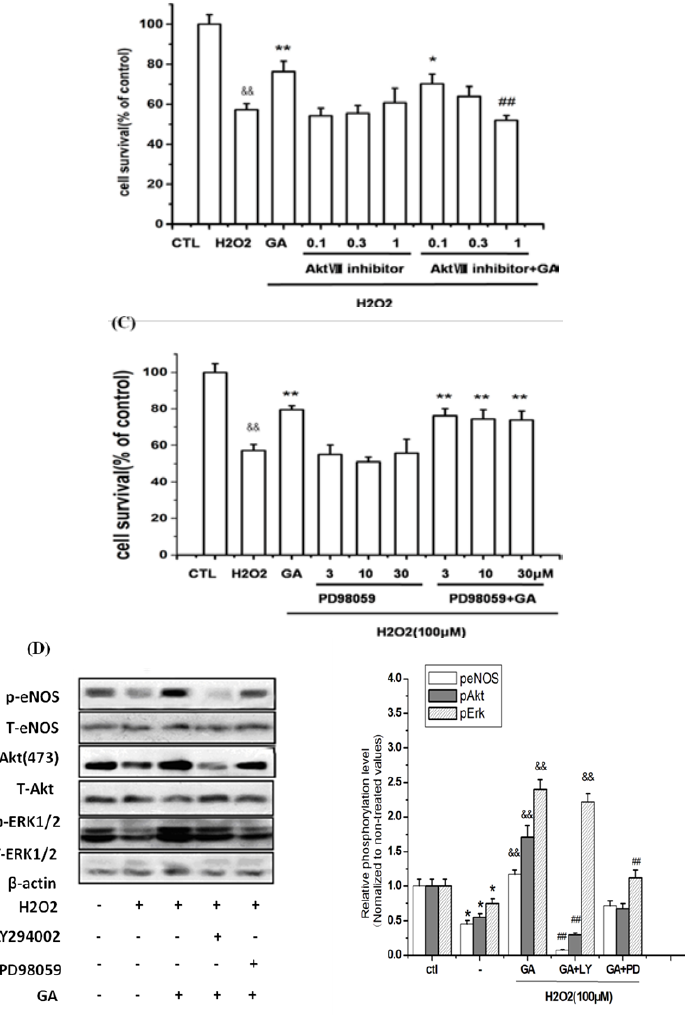
Figure 6. PI3K inhibitor LY294002, and Akt inhibitor Akt inhibitor VIII, respectively, blocked the effect of GA on RGC-5 cells. Cells pretreated with the PI3K inhibitor LY294002, Akt inhibitor Akt inhibitor VIII, and MEK inhibitor PD98059, respectively, were treated with H 2 O 2 in the absence or presence of GA (10 μM). The cell viability and the phosphorylation levels of Akt, eNOS and ERK1/2 were determined. ( A ) PI3K inhibitor LY294002 dose- dependently blocked the protective effect of GA on RGC-5 cells; ( B ) Akt inhibitor Akt VIII dose-dependently blocked the effect of GA on RGC-5 cells; ( C ) MEK inhibitor PD98059 showed no effect; ( D ) H 2 O 2 blocked the phosphorylation of Akt, eNOS and ERK1/2, while GA reversed the blockade. LY294002 completely inhibited the GA-activated phosphorylation of Akt and eNOS. PD98059 partially inhibited the GA-activated phosphorylation of ERK1/2 in a statistically significant manner, while it partially inhibited the GA-activated phosphorylation of Akt and eNOS in a non-statistically significant manner. Results were expressed as the percentage of the corresponding control value, which was set at 100%. Data are shown as the mean ± SEM. and representative assays from at least three independent experiments. && p < 0.05 vs. control group, * p < 0.05, ** p < 0.01 vs. H 2 O 2 -treated group; ## p < 0.05 vs. GA-treated